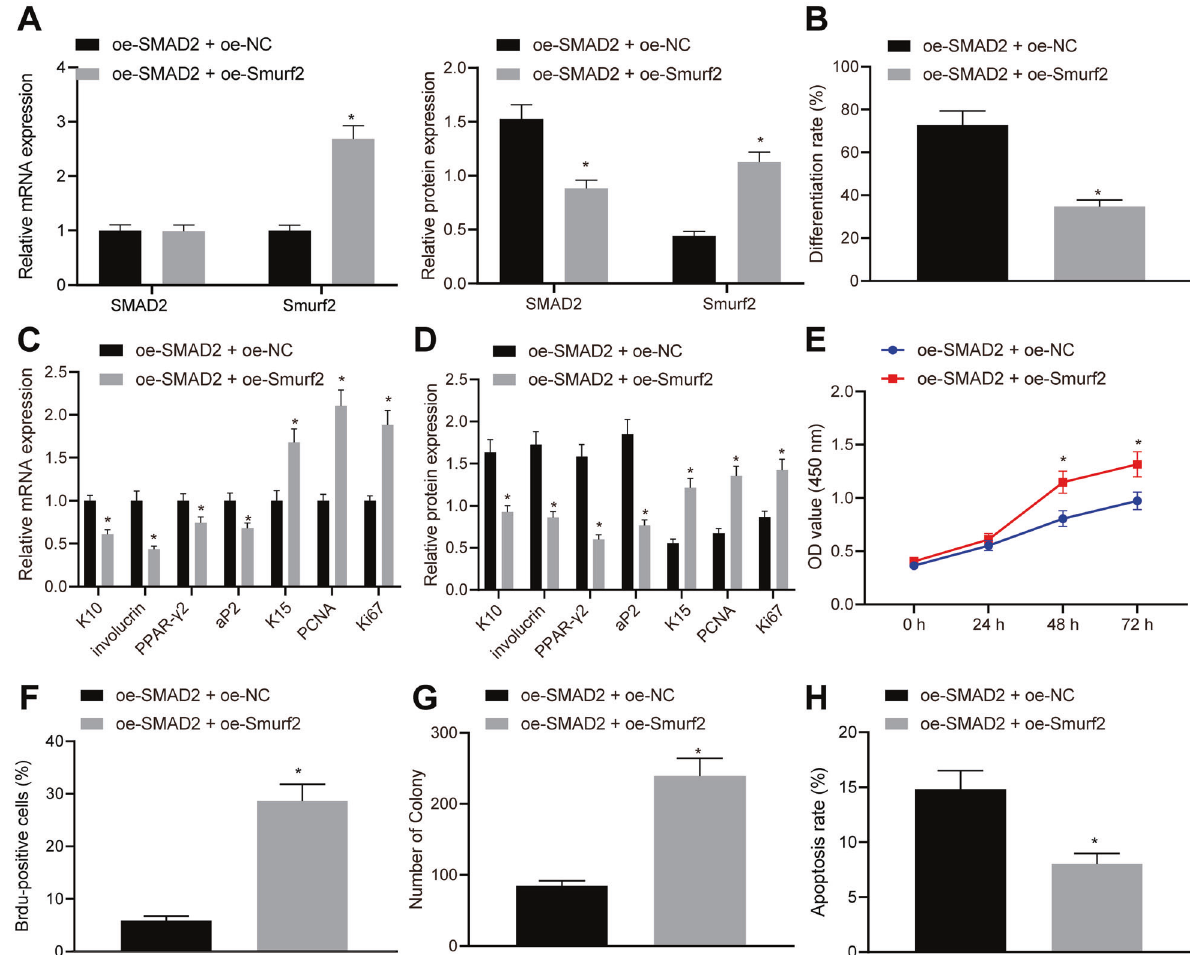
Fig. 3 Smurf2 degrades SMAD2 to inhibit the differentiation of HFSCs and promote their proliferation. A SMAD2 and Smurf2 mRNA and protein levels in HFSCs overexpressing SMAD2 alone or transduced with lentivirus-packaged oe-Smurf2 in combination determined by RT- qPCR and western blot assay, with β -actin as internal reference. B Cell differentiation determined by oil red O staining. mRNA ( C ) and protein ( D ) levels of epidermal differentiation markers (K10 and involucrin), adipogenesis markers (PPAR- γ 2 and aP2), keratinocyte-speci fi c marker (K15), and proliferation-related markers (PCNA and Ki67) in HFSCs after SMAD2 overexpression alone or Smurf2 overexpression in combination measured by RT-qPCR and western blot assay, with β -actin as internal reference. E Cell viability after SMAD2 overexpression alone or Smurf2 overexpression in combination determined by CCK-8 assay. F Cell proliferation in response to SMAD2 overexpression alone or Smurf2 overexpression in combination assessed by BrdU labeling. G The number of colonies formed in HFSCs after SMAD2 overexpression alone or Smurf2 overexpression in combination. H Cell apoptosis in response to SMAD2 overexpression alone or Smurf2 overexpression in combination determined by fl ow cytometry. * p < 0.05 vs. oe-SMAD2 + oe-NC group. Data are expressed as mean ± standard deviation. Data comparison between two groups was performed by unpaired t test, while data between multiple groups were compared by one-way ANOVA with Tukey ’ s post hoc test. Data at different time points were compared by repeated measures ANOVA with Bonferroni post hoc test. Each cell experiment was repeated 3 (Fig. 3F) and colony formation abilities (Fig. 3G) of HFSCs overexpressing SMAD2, accompanied with suppressed apoptosis (Fig. 3H). These results suggested that Smurf2 impeded the apoptosis and differentiation of HFSCs while stimulating cell proliferation through degradation of SMAD2.